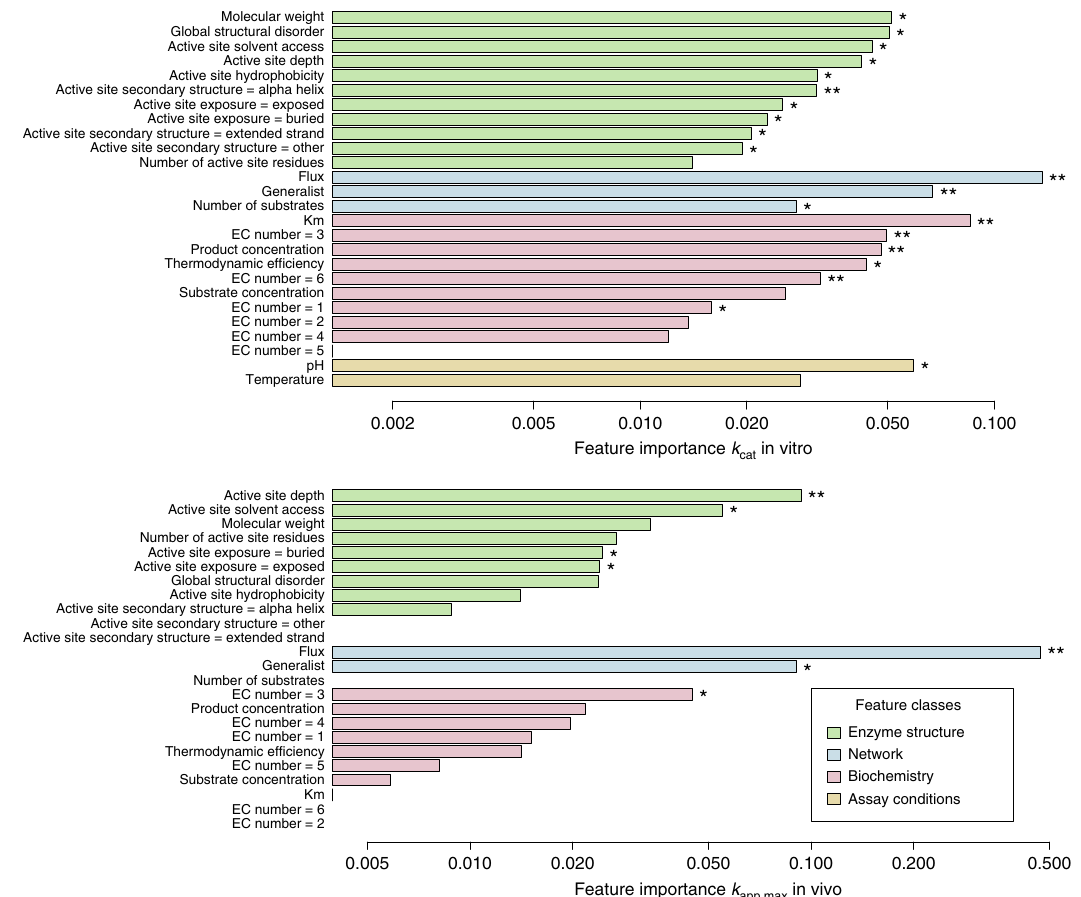
Fig. 3 Feature importance in random forest models for in vivo and in vitro turnover numbers. The relative importance as measured by the average decrease in out-of-bag mean squared error (MSE) across trees that results from randomly permuting a given feature (scaled by the standard deviation) is shown. Missing bars indicate permutation importance smaller or equal to zero. The statistical signi fi cance of feature importance was evaluated using a permutation test based on 500 permutations of the response variable per model; * p -value < 0.05, ** p -value < 0.005. Spearman rank correlation between the importance estimates of the two models is 0.47 ( p < 0.021, n = 24, S = 1214, see Methods), ignoring assay-related features that are not used in the model for k